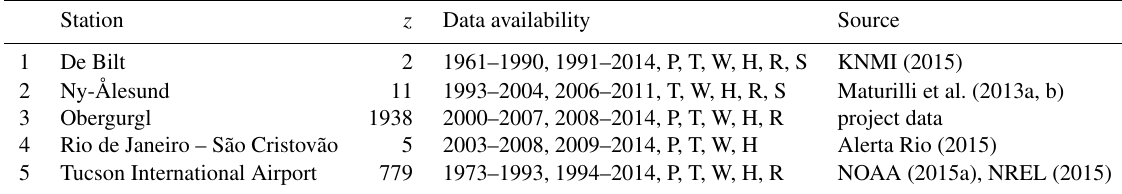
Table 1. List of AWS investigated in this study. The elevation of each station z is given in metres above sea level. Data availability refers to the available station recordings (hourly data). The first period of time refers to the calibration period, whereas the second period is preserved for validation purposes. P is precipitation, T is air temperature, H is humidity, W is wind speed, R is solar radiation, and S is sunshine duration. The location of each station is shown on the map in Fig. 2.